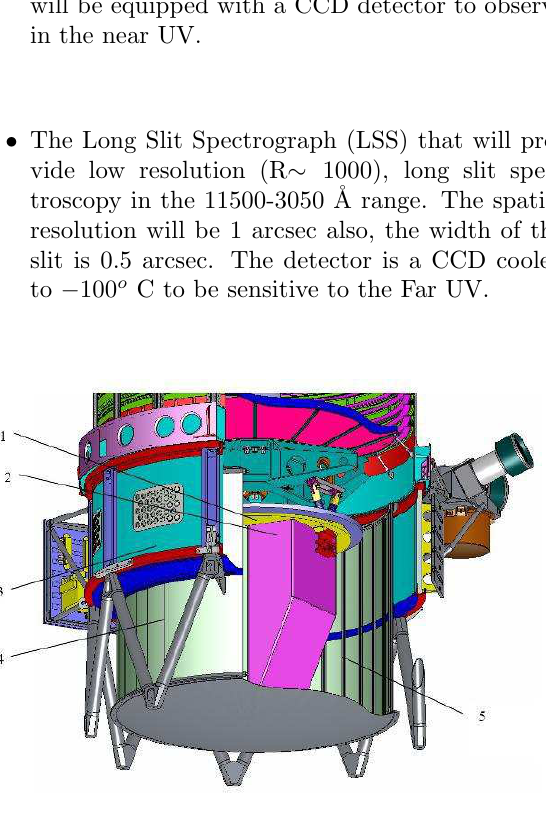
Figure 2: The instruments compartment in WSO- UV.The numbered sections correspond to: [1] optical bench with ISSIS and WUVS mounted, [2] spectro- graphs, [3] cylinder inset of the instruments compart- ment, [4] protective cover of the instruments compart- ment and [5] heat